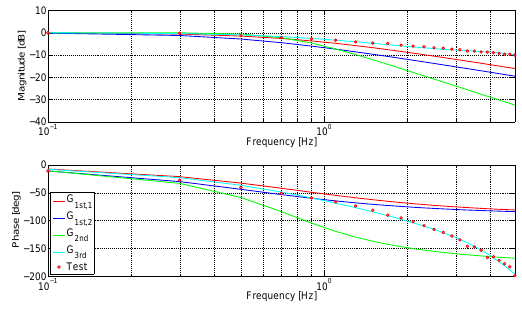
Figure 16: Comparison of different estimated transfer